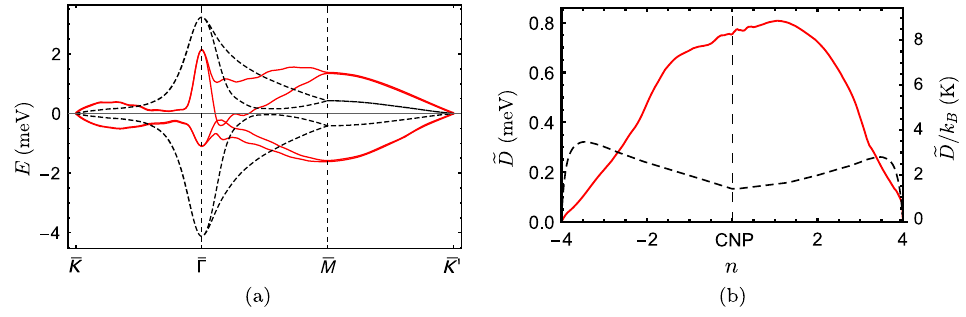
˜ D for the models in Ref. [17] (in black) and